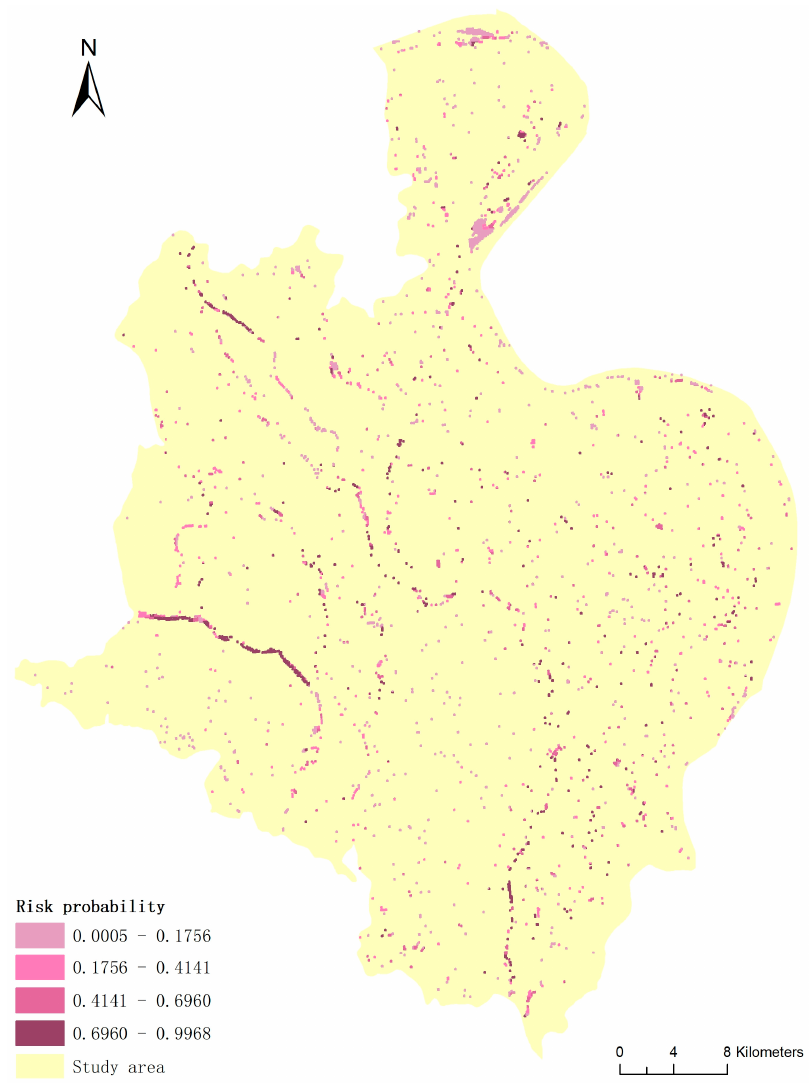
Figure 4. Potential habitats in dispersion ranges of Oncomelania hupensis after a flood.